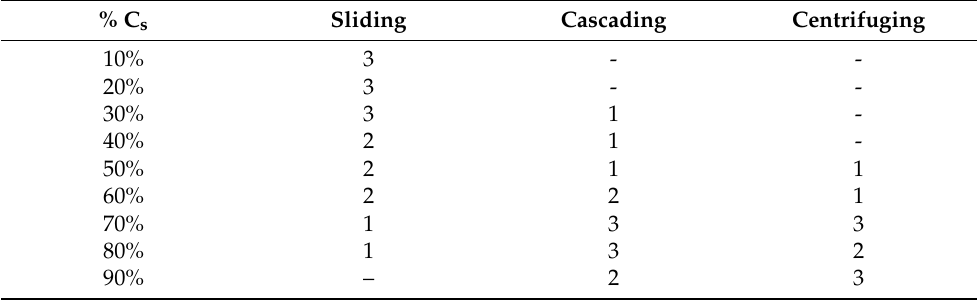
Table 1. Empirical description of the grinding actions at different percentages of C s . Numbers from 1 to 3 indicate the ascending degree of action (adapted from Gupta and Yan 2016